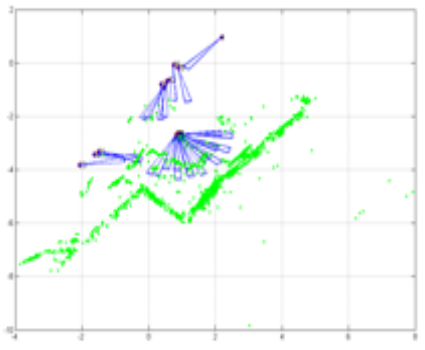
Figure 3: The reconstructed 3D scene (point cloud)